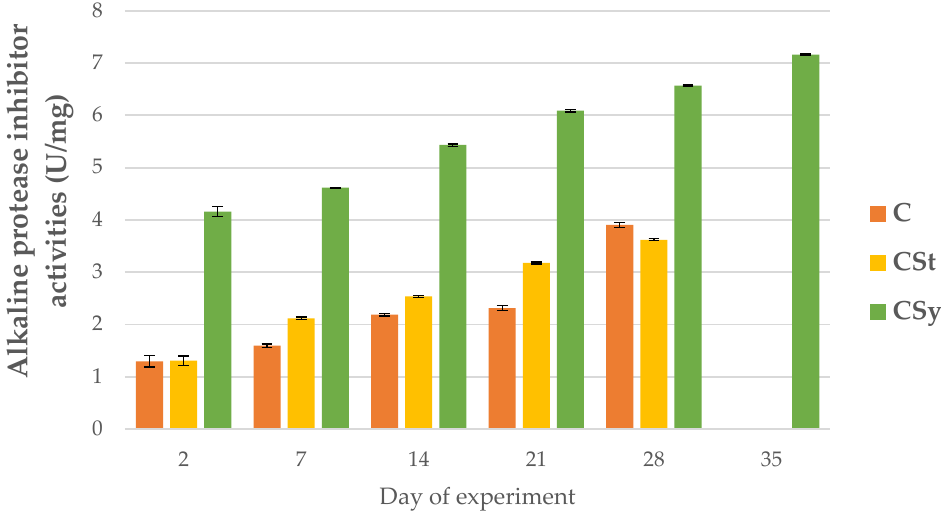
Figure 7. Alkaline protease inhibitor activities in the 2, 7, 14, 21, 28, 35-day-old honey bees’ hemolymph after two methods of supplementation with hemp extract: C–control (pure sugar syrup), CSy – hemp extract in syrup, CSt – hemp extract on strips. (Two-Way ANOVA: supplementation method: F (2, 156) = 225.68, p = 0.0000, se ± 0.121993–0.133636; days of supplementation: F (4, 143) = 10359, p = 0.0000, se ± 0.009407 – 0.016; supplementation method × days of supplementation F (8, 143) = 266.45, p = 0.0000, se ± 0.016 – 0.016866.